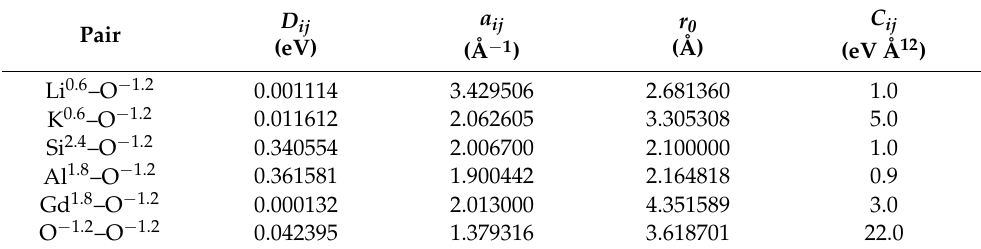
Table 1. Potential Parameters used for the MD simulations. Adapted from